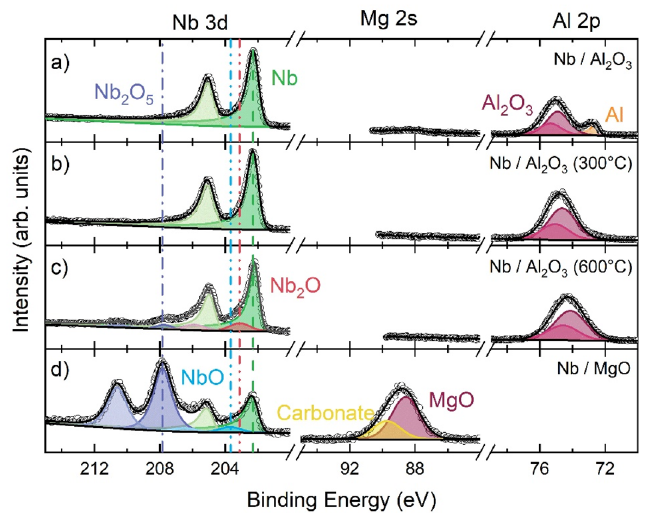
Figure 4. XPS characterisation illustrating the Nb 3d, Al 2p core levels for Al 2 O 3 capped Nb ( a ) unannealed, annealed at ( b ) 300 °C and ( c ) 600 °C and ( d ) the Nb 3d and Mg 2 s core levels for MgO capped Nb. The carbonate peak observed at roughly 90 eV can be explained simply by atmospheric contaminants. All Nb films are 30 nm thick. The binding energies for all elements and compounds seen within this figure are corroborated by those ascertained in previous works 50–58